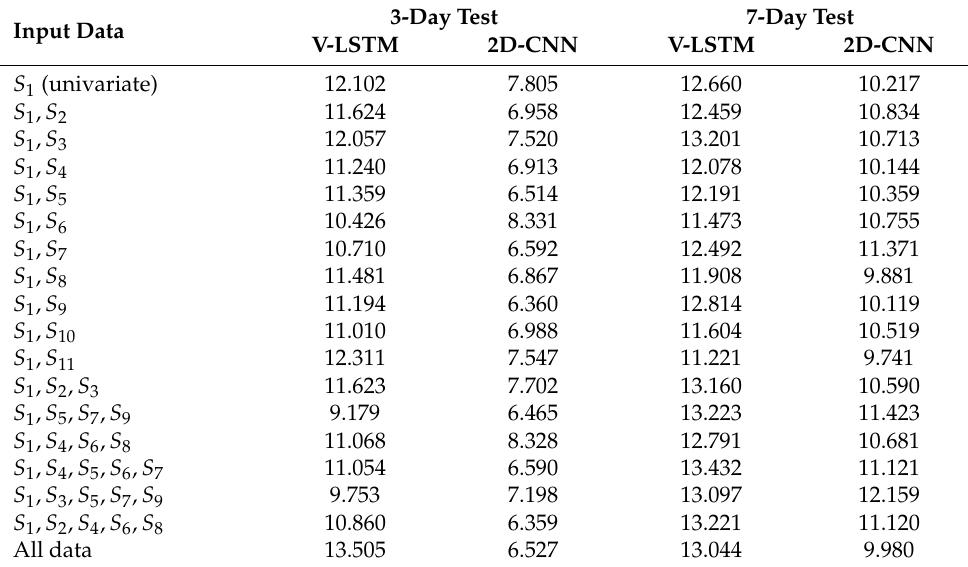
Table 4. Average RMSE for April 2018 tests, carried out by using V-LSTM and 2D-CNN models and different combinations of time series.